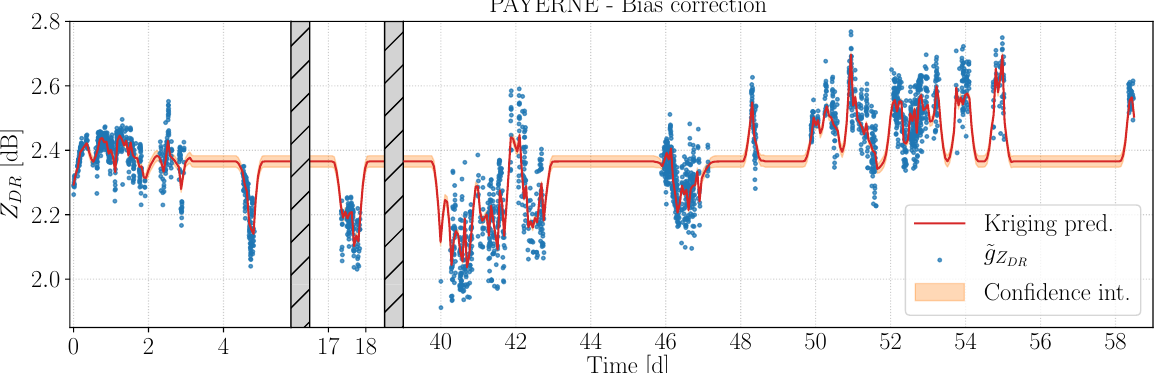
Figure 5. Evolution of the calibration bias (in red) in time for the PAYERNE campaign, superimposed to the median Z DR value of each scan (in blue). The confidence interval (in orange) surrounding the curve is equal to three times the standard deviation of the kriging estimation, equivalent to 95% of the confidence interval for continuous unimodal distributions [33]. The same time intervals without measurements as in Figure 2 are removed and substituted by a gray hatched